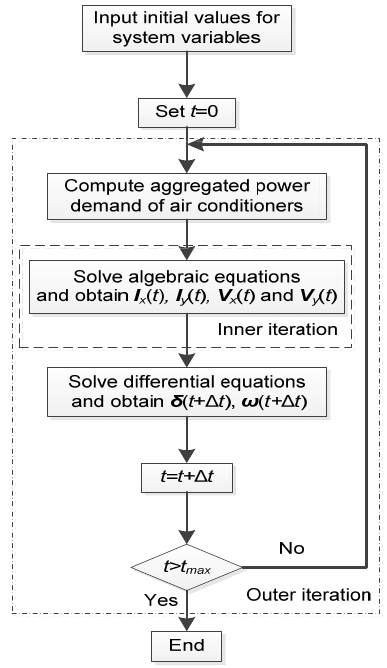
Figure 6. Solving process for power system